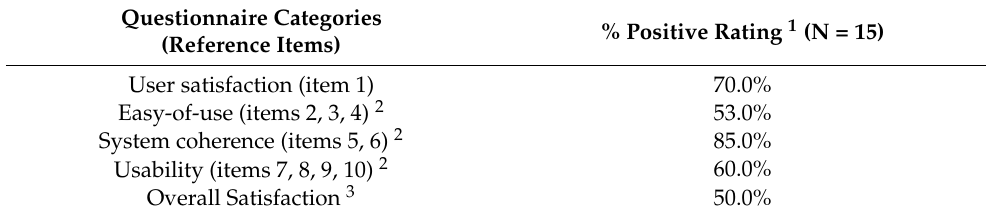
Table 6. Summary of positive rating percentages on the categories of the SUS